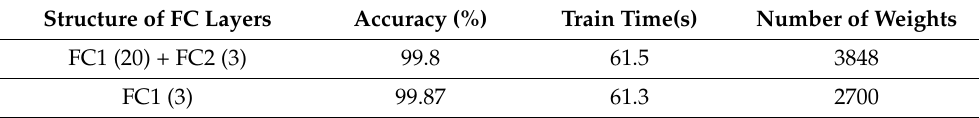
Table 1. Different structures of FC